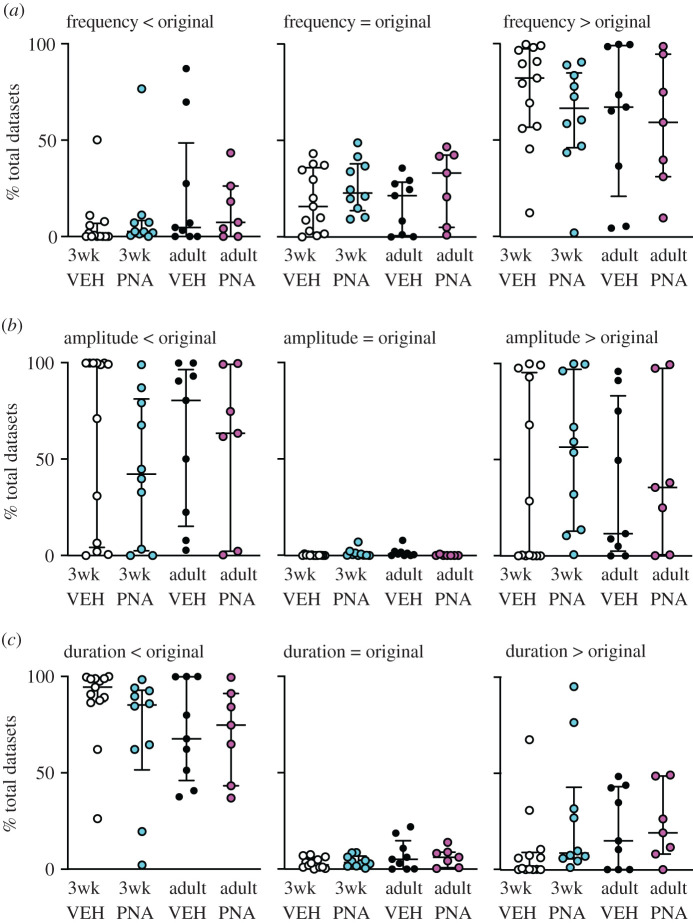
GnRH neurons lower the frequency and increase duration of long-term peaks in action potential firing. Cluster analysis of MC datasets for peak frequency (a), amplitude (b) and duration (c) compared with original data. Graphs show individual values, median and interquartile range. Each dot shows the percentage of total datasets from an individual cell that is less than (left), equal to (centre) or greater than (right) the original data's value for that parameter.